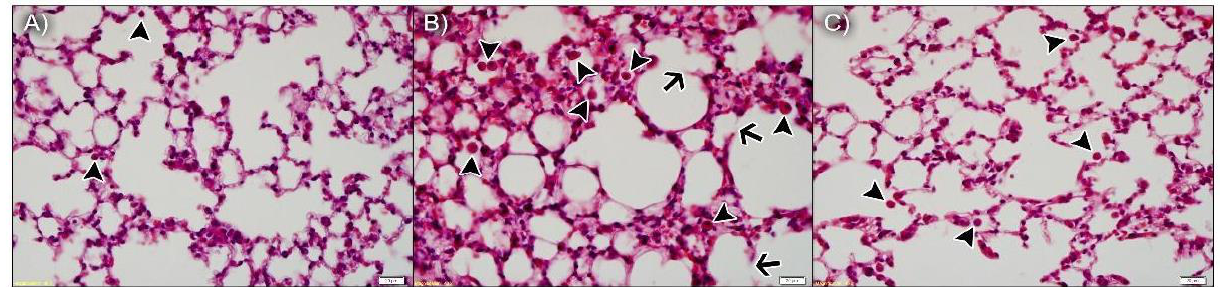
9 of 19 Figure 3. Thermal stability of nanoparticles. ( A ) TGA/DrTGA from 0 to 800 °C of npBL. ( B ) TGA/DrTGA from 0 to 800 °C of npBX. ( C ) DSC curves of bixin, PCL, P 188, npBL and npBX. 3.3. npBX Prevents ALI Induced by CS Exposure 3.3.1. npBX Preserves Pulmonary Histoarchitecture As anticipated, the lung parenchyma was preserved in animals exposed to ambient air and npBL (Figure 4A), with only a few resident leukocytes, indicating npBL admin-